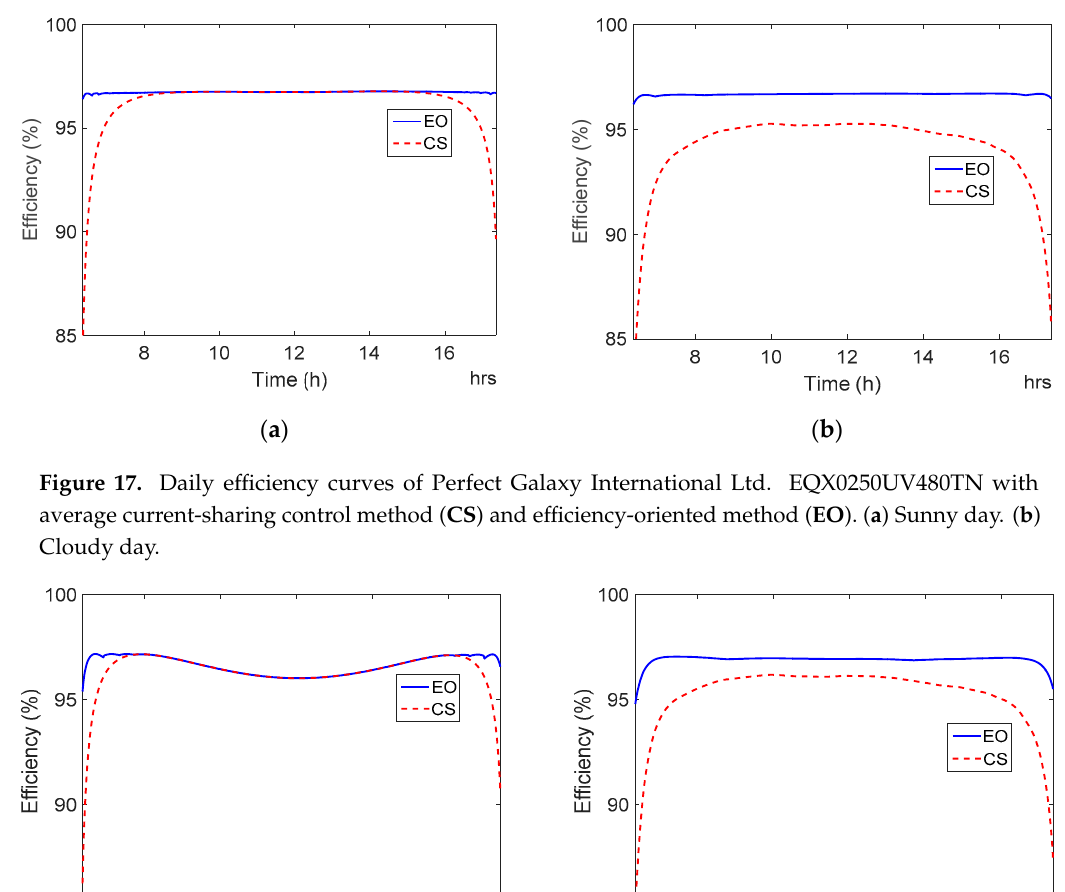
Figure 17. Daily efficiency curves of Perfect Galaxy International Ltd EQX0250UV480TN with average current-sharing control method ( CS ) and efficiency-oriented method ( EO ). ( a ) Sunny day. ( b ) Cloudy day.